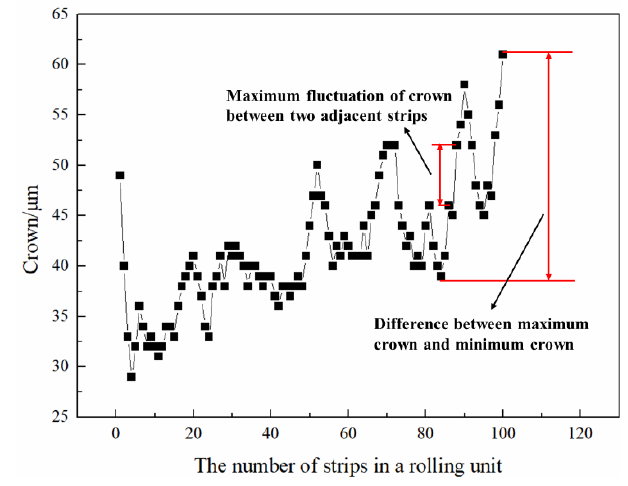
Figure 8. Crown fluctuation quantitative index.